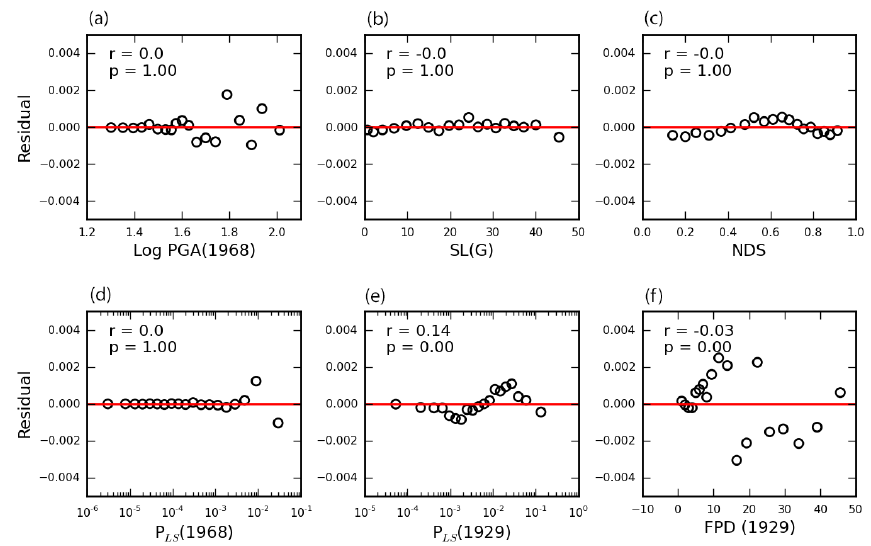
Figure 13. Distributions of P LS residuals for the 1968 earthquake, hindcast using Eq. (6). Panels (a) – (c) show the residuals for this model (observed P LS minus predicted P LS ) plotted against each of the model predictors. Panel (d) shows the model residuals plotted against the predicted P LS . Panels (e) and (f) show the model residuals plotted against predicted P LS for the 1929 earthquake and distance from the 1929 coseismic fault, respectively. All residuals are calculated by aggregating probabilities across 20 equal quantile bins of the x variable. Positive residuals indicate that the model under-predicts P LS and negative residuals indicate that the model over-predicts P LS . Note that the amplitude of the plotted residuals varies due to binning and aggregating probabilities with the different predictor variables. For each plot, the coefficient ( r ) and significance ( p ) of correlation in the residuals are given. These were derived by adding each x variable into a logistic regression analysis of P LS predicted using Eq. (6) and observed landsliding. In this respect we test the coupled significance of SL and G as they feature in the